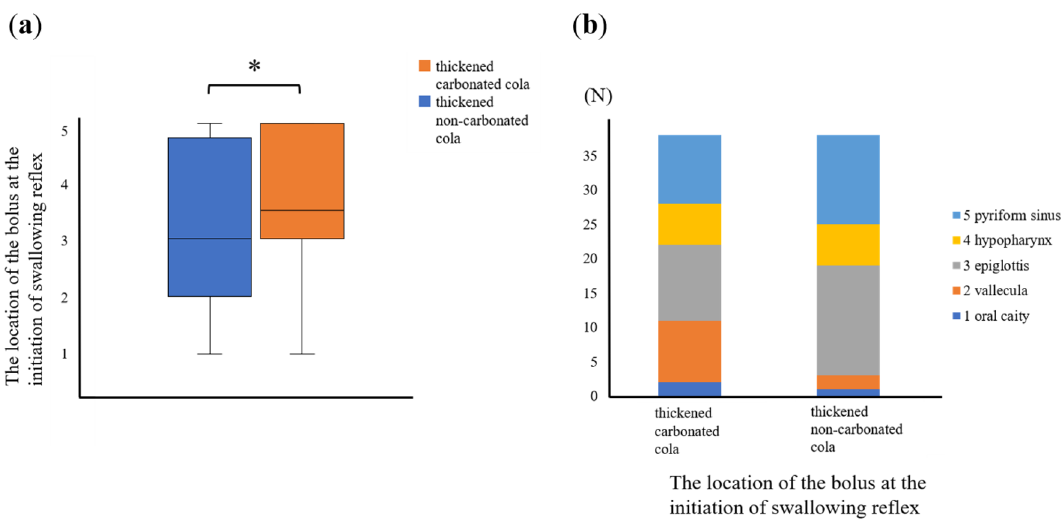
Figure 2. Comparison of the location of bolus at the initiation of swallowing between thickened carbonated cola and thickened non-carbonated cola ( a ) box plot; * p < 0.05, ( b ) bar